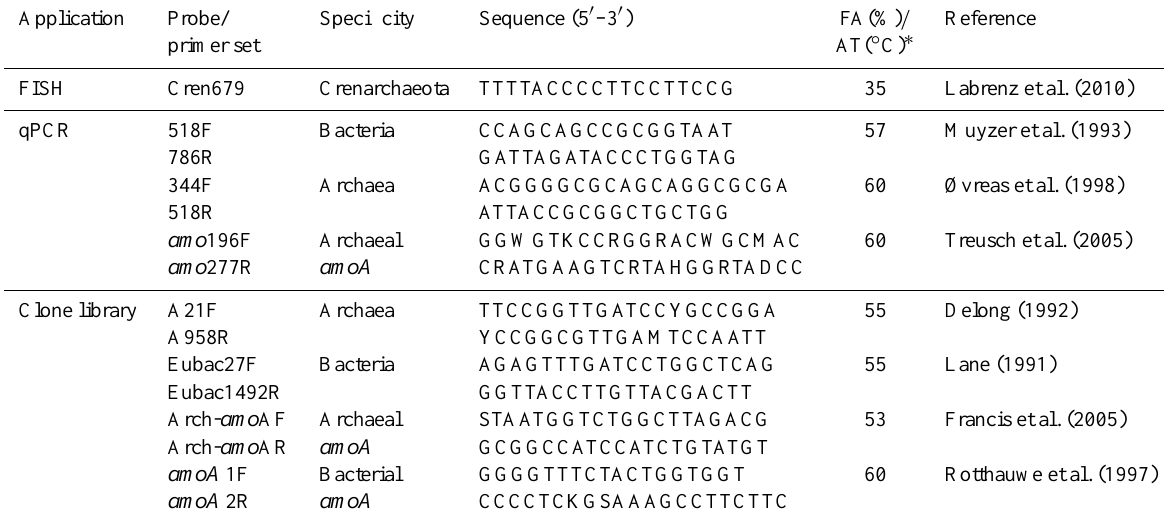
Table 1. FISH probe and PCR primer pairs used in this study.